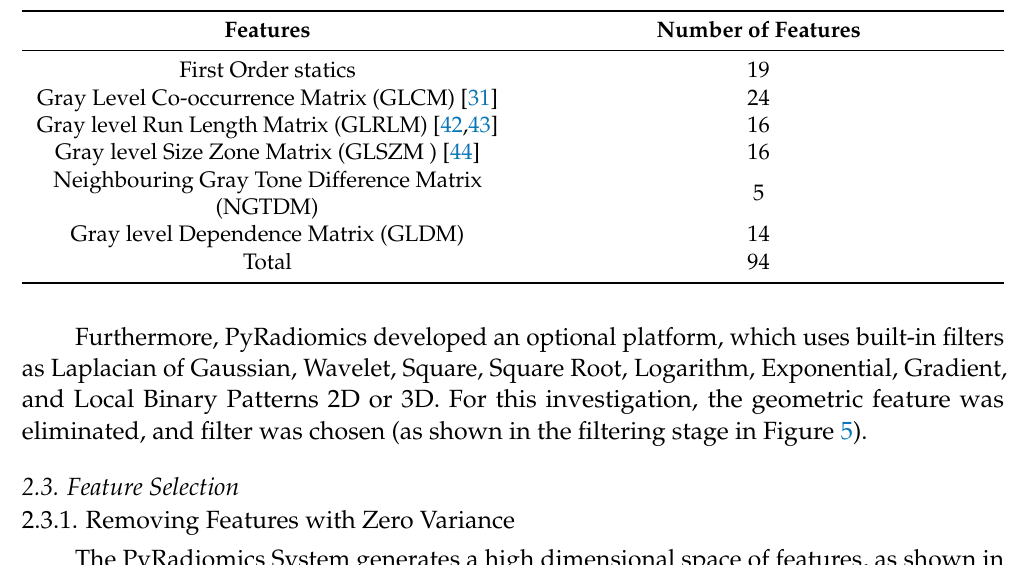
Table 2. Radiomics features for each class (See Appendix